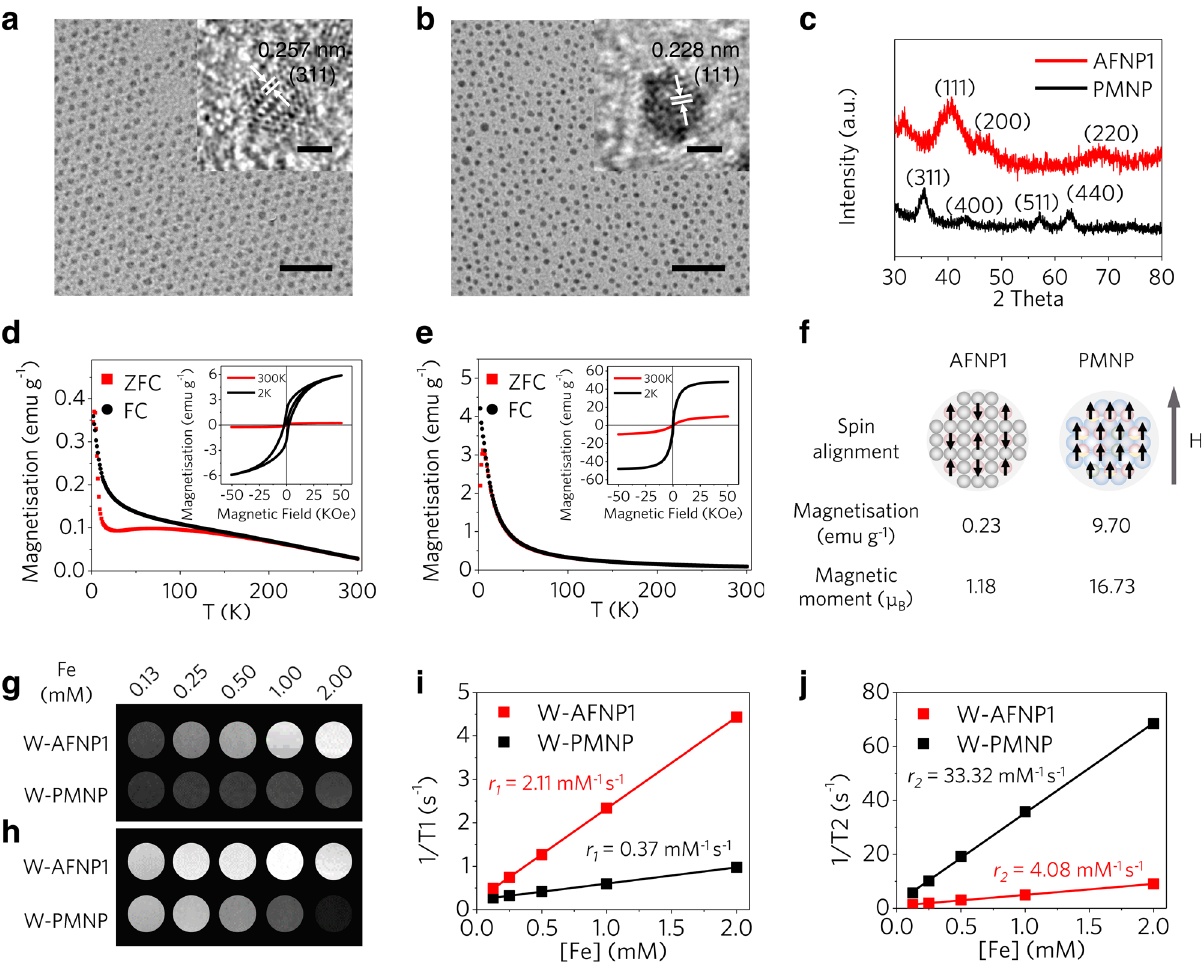
Fig. 3 Effect of magnetic moments and spin alignments of nanoprobes on UHF MRI performance. a , b TEM images of ( a ) PMNP and ( b ) AFNP1, scale bar = 20 nm. The inset images in panels a and b are the high-resolution transmission electron microscopy (HRTEM) images of PMNP and AFNP1, respectively, scale bar = 1 nm. c XRD patterns of AFNP1 (FePt 3 ; JCPDS no. 29-0716) and PMNP ( γ -Fe 2 O 3 ; JCPDS no. 39-1346). d , e Temperature- dependent magnetisation curves ( M – T ) for ( d ) AFNP1 and ( e ) PMNP, measured after ZFC and FC at the applied fi eld of 100 Oe. Their inset images show the M – H curves at 2 K and 300 K for ( d ) AFNP1 and ( e ) PMNP. f Schematics of spin alignments of magnetic components at the external magnetic fi eld, as well as the magnetic moments and magnetisation values of AFNPs and PMNPs (red circles, grey circles and blue circles represent the Fe atoms, Pt atoms and oxygen atoms, respectively). g T1-weighted and h , T2-weighted MR images of W-AFNP1 and W-PMNP. i T1 relaxation rate (1/T1, s − 1 ) and j T2 relaxation rate (1/T2, s − 1 ) plotted against Fe concentration (mM) for W-AFNP1 and W-PMNP. In a , b , experiments were repeated three times independently. Source data are provided as a Source Data